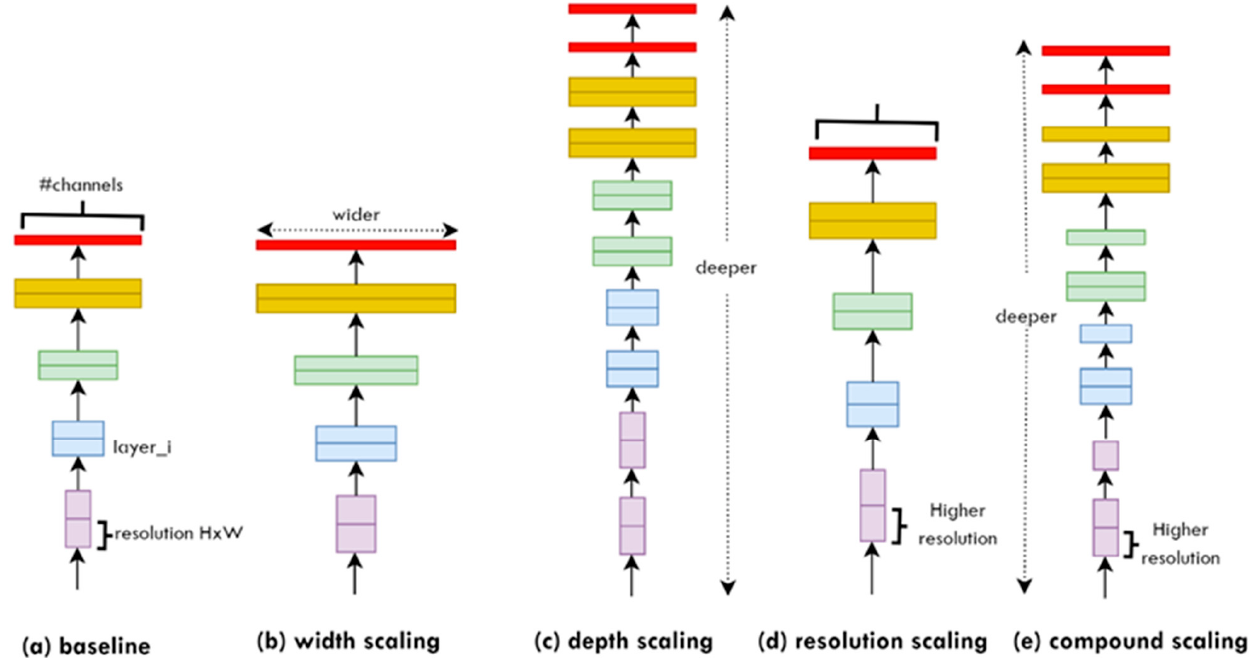
Figure 4. Comparison of different scaling methodologies ( a – e ). In contrast to conventional scaling methods ( b – d ), which arbitrarily scale a single dimension of the network, the compound scaling method uniformly scales up all dimensions in a principled way [32].